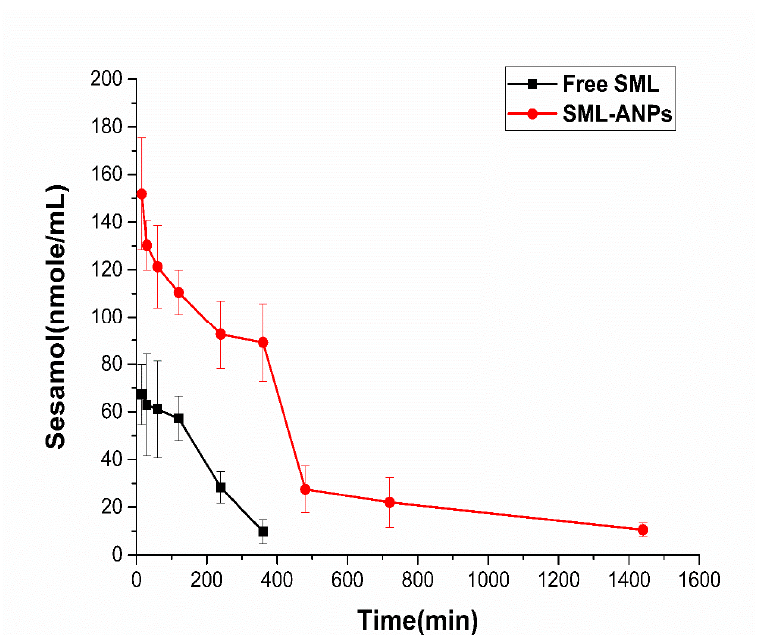
Figure 5. Plasma concentration–time profiles of SML after IV single dose (15 mg/kg) of SML and SML-ANPs. Values are presented as means ± SD (n in each group = 4).